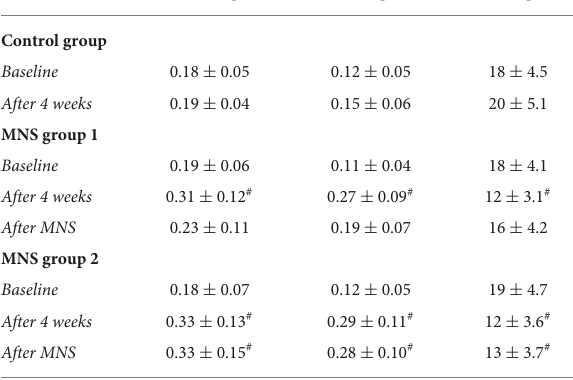
TABLE 3 Levels of the tumor necrosis factor-alpha (TNF- α ), interleukin-6 (IL-6), and acetylcholine (Ach) in the plasma in control group, median nerve stimulation (MNS) group 1, and MNS group 2.